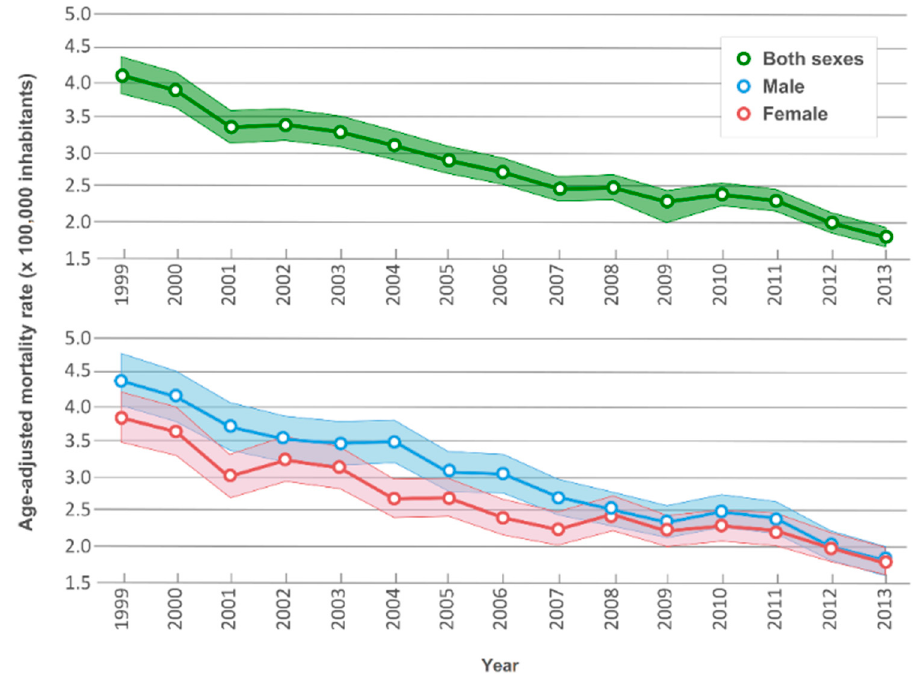
Figure 1. Time trends in age-adjusted mortality rates per 100,000 inhabitants for rare congenital anomalies. Shading represents 95% confidence intervals.